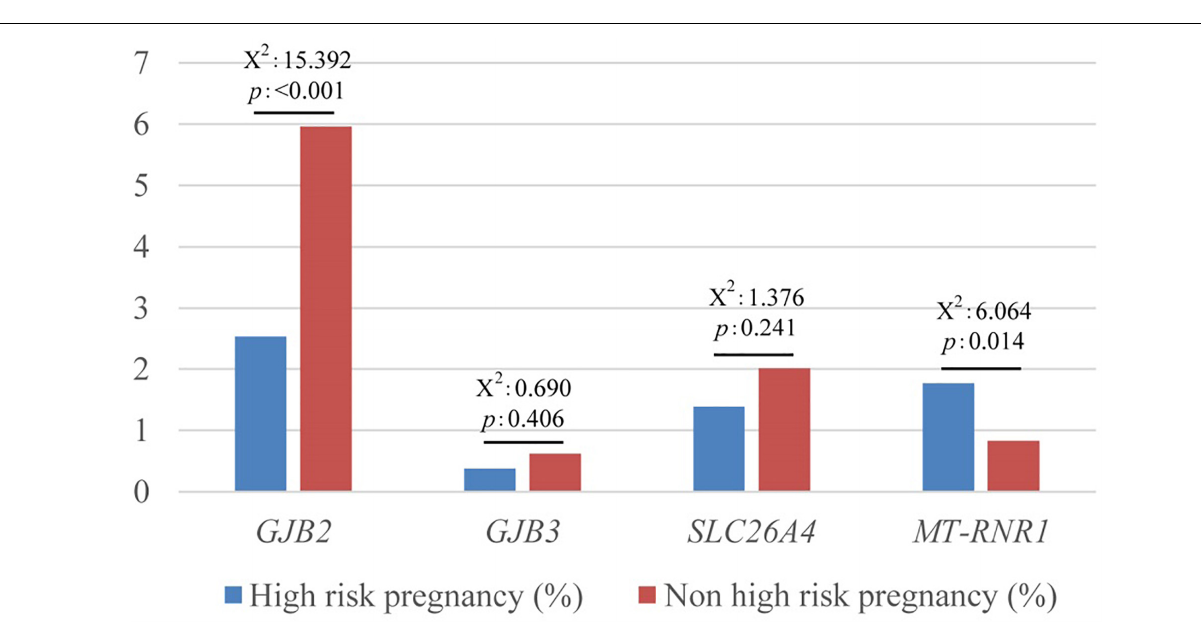
FIGURE 4 | Comparison of high-risk and non-high-risk pregnancy in deafness gene